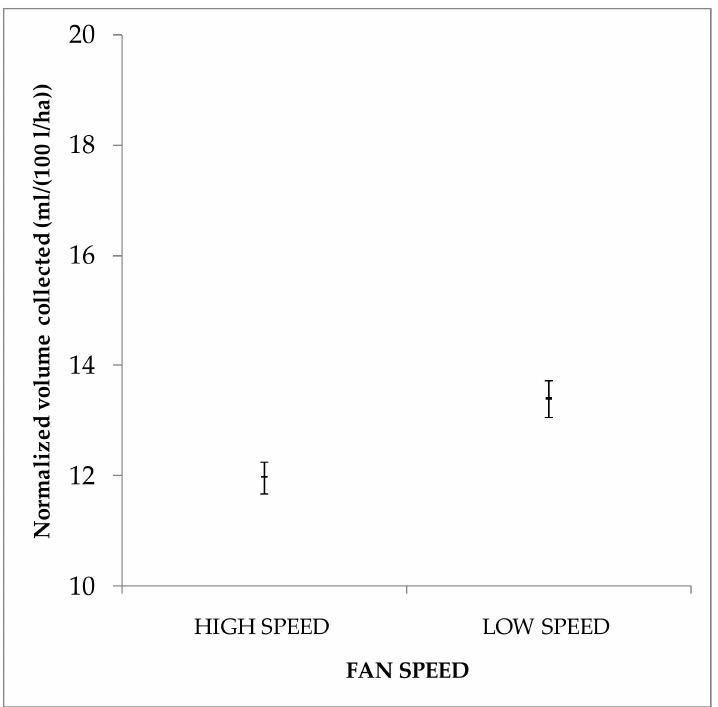
Figure 16. Fan speed effect on the normalized volume collected in the canopy zone (mean ± SE) with the C1 sprayer.